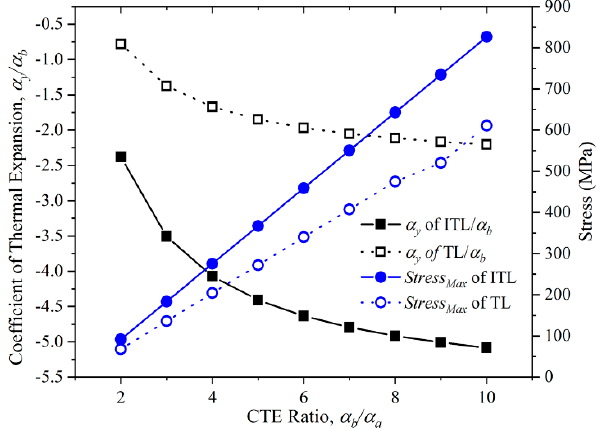
Figure 6. The Y-direction CTE and the maximum stress of the ITL with the varying CTE ratio of the two constituents and those of the triangular lattice.